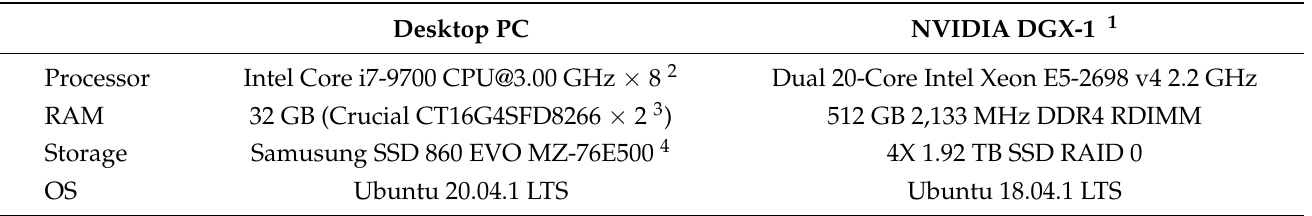
Table 2. Specifications of computers used to calculate required time and memory